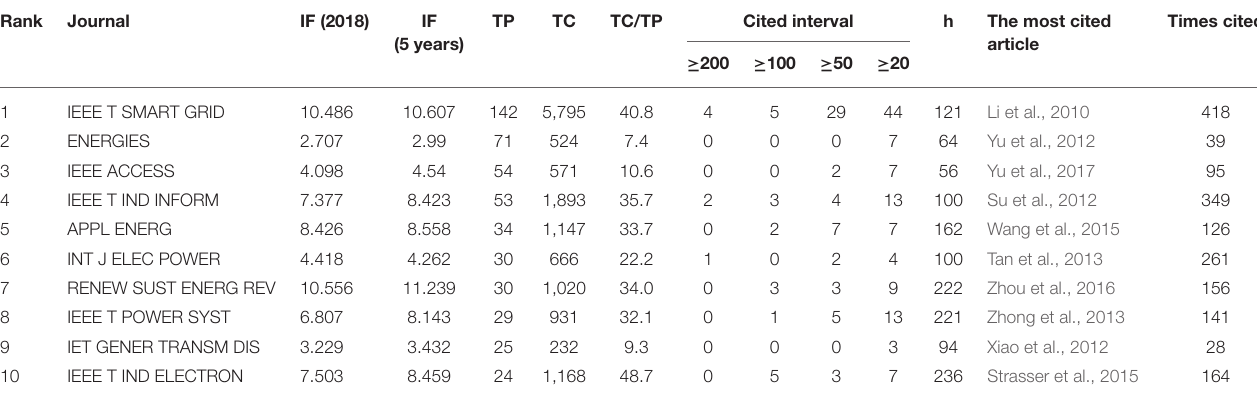
TABLE 3 | The top 10 most productive journals on SG by Chinese scholars.